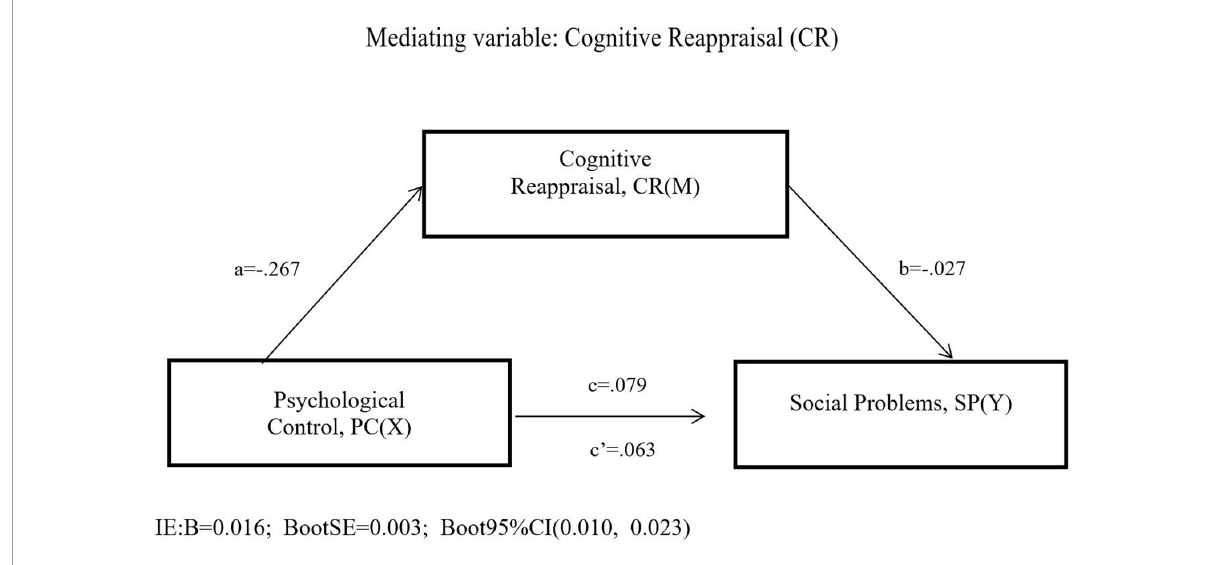
FIGURE2 The mediation model of cognitive reappraisal.